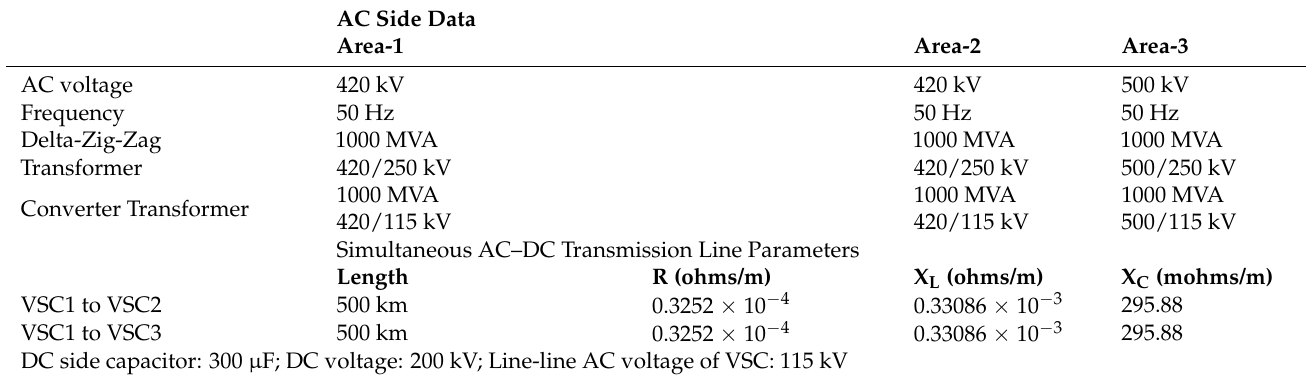
Table 1. System data used for